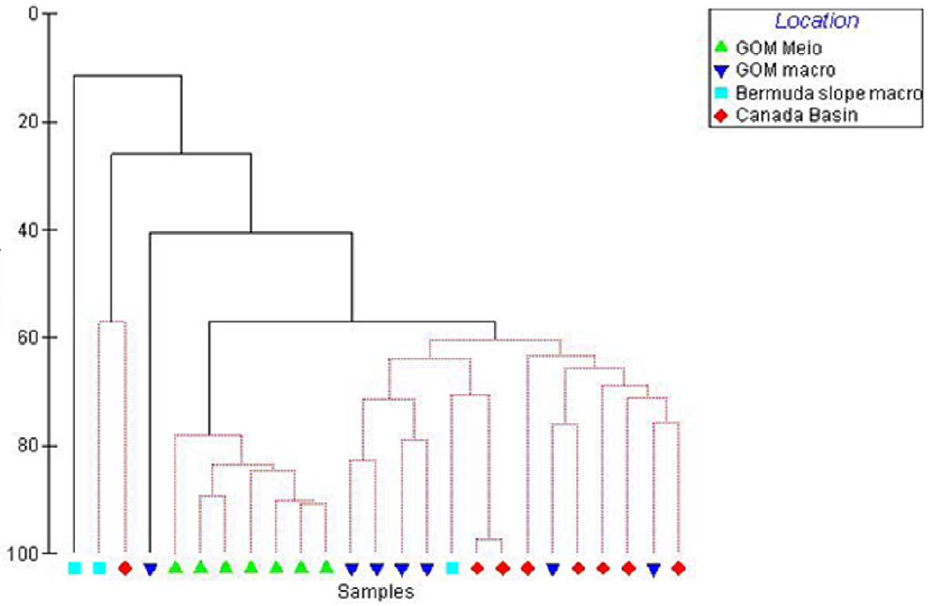
Figure 4. Cluster analysis with SIMPROF test on similarity of nematode families from meio- and macrobenthos in GOM and from macrobenthos in Canada Basin and Bermuda transect. doi:10.1371/journal.pone.0014491.g004 PLoS ONE |